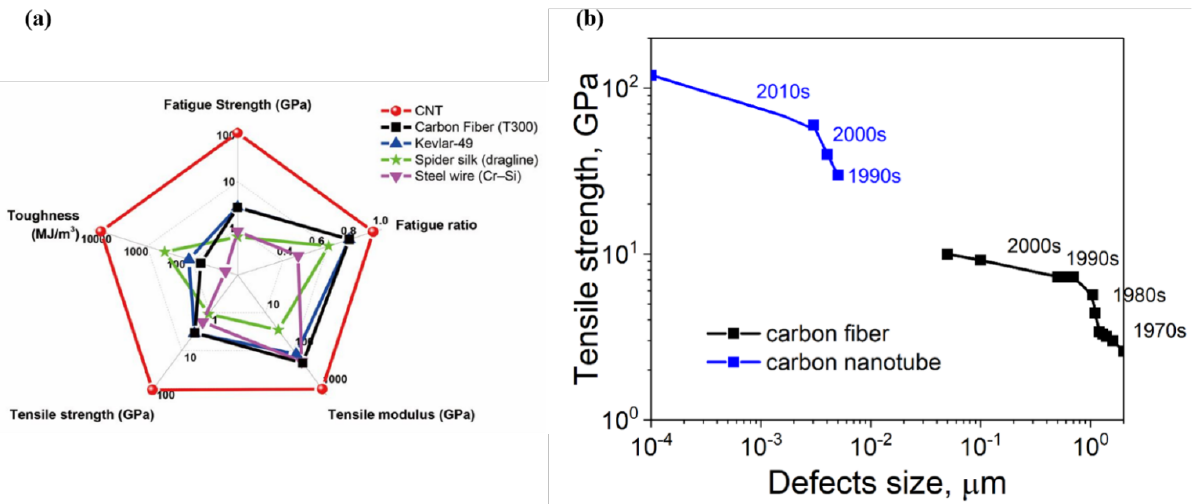
Figure 1. ( a ) Comparison of mechanical performance between CNTs and some high−performance materials. Reproduced with permission from [15]. Copyright 2020, American Association for the Advancement of Science. ( b ) Evolution of the tensile strength of CNTs and CFs at different defect sizes. The data are collected in [4,7,10,15] .